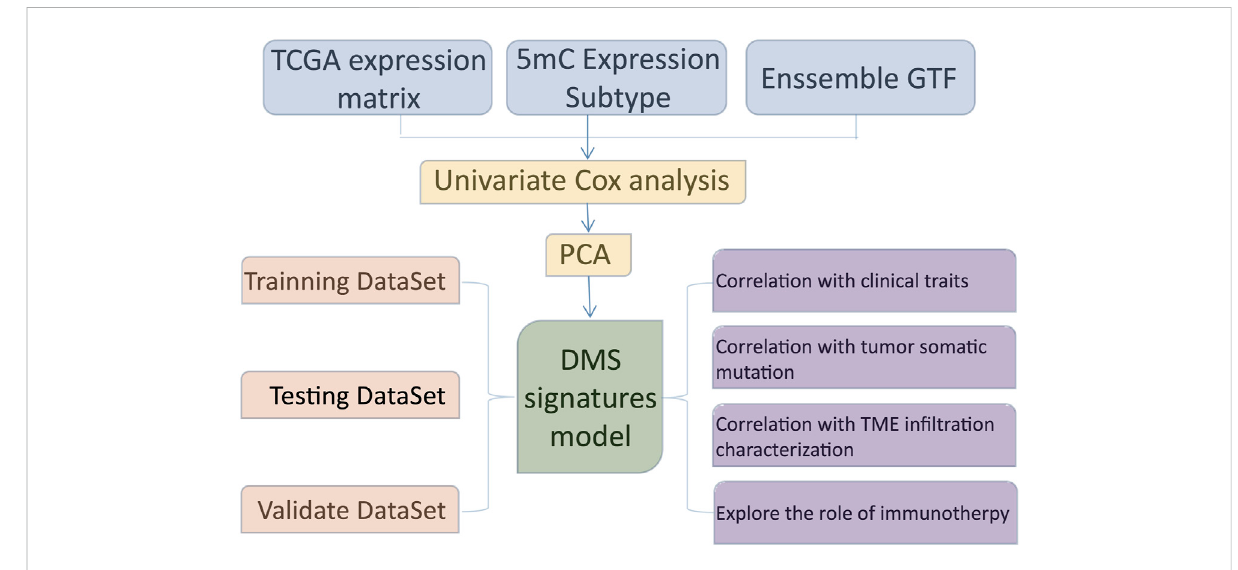
FIGURE 1 The overall design of this